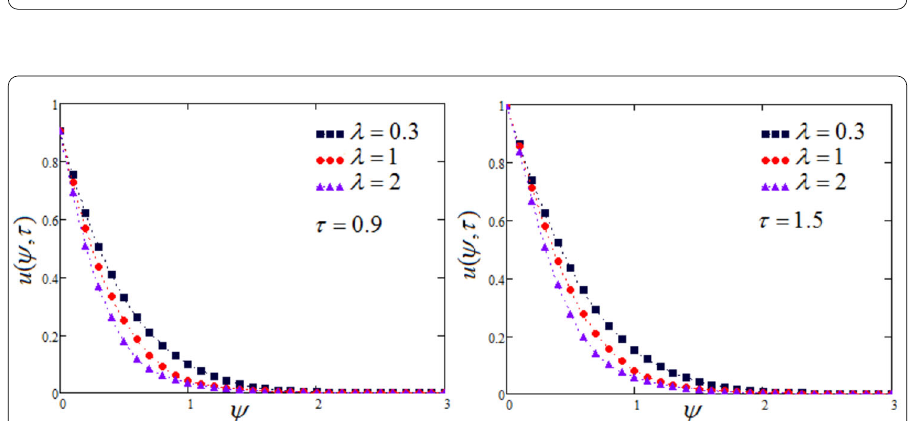
Figure 10 Velocity profiles of a Maxwell fluid for various values of λ at two different times